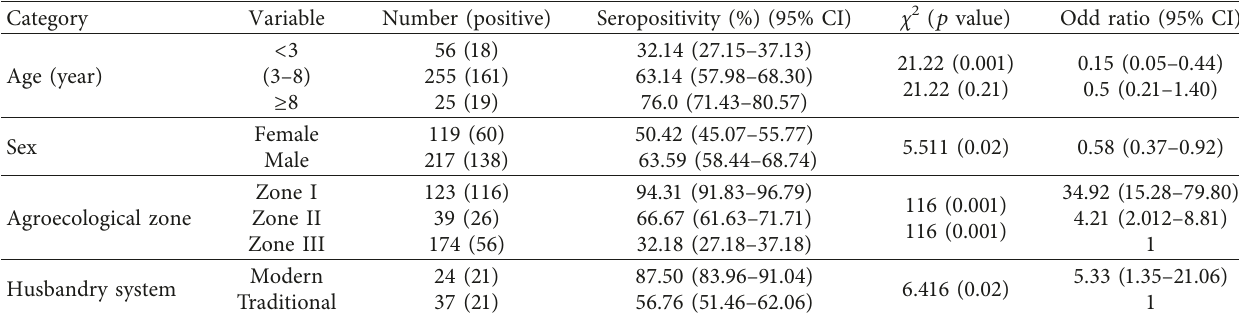
Table 3: Factors affecting the dissemination of African horse sickness in